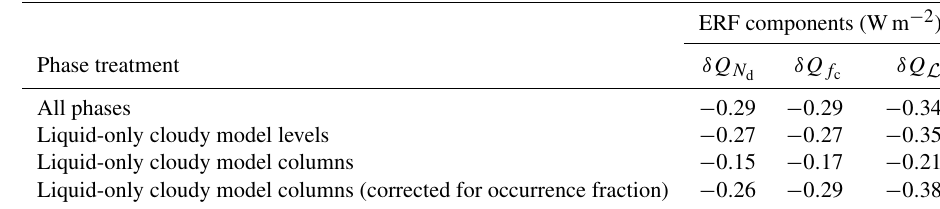
Table 2. Dependence of diagnosed ERF aci components on treatment of thermodynamic phase.